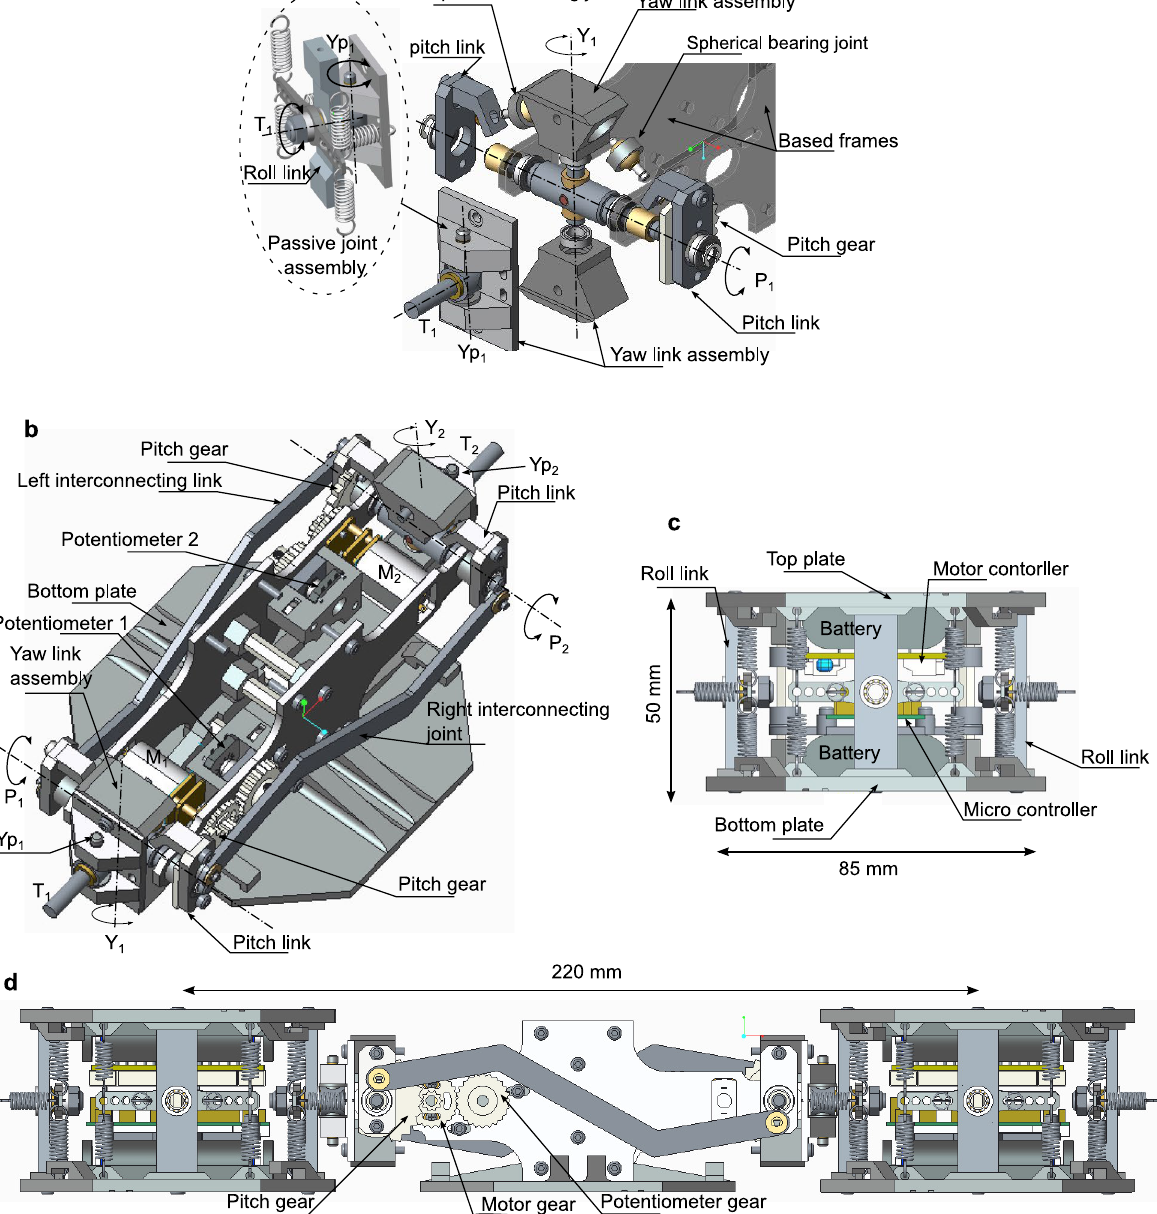
Fig. 8 Mechanical design of joint mechanisms and modules. a Mechanical design of the universal joint assembly. b Mechanical design of JM. c Mechanical design of CM. d Complete mechanical design of connection between CM and